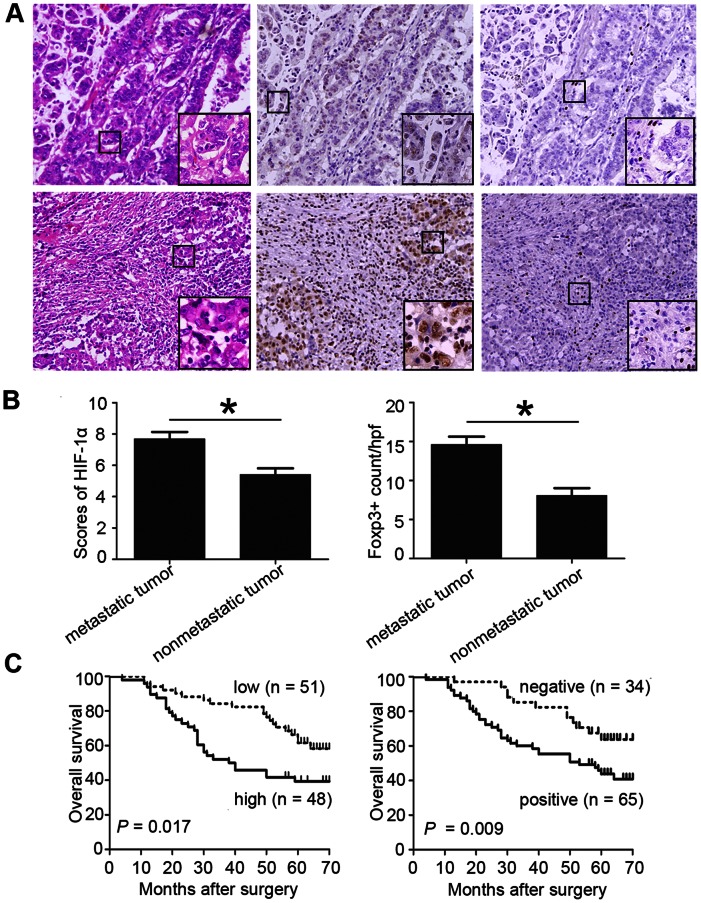
HIF-1α and Foxp3 expression in gastric cancer specimens.(A) Foxp3 and HIF-1α expression in gastric cancer specimens (serial sections) were determined by H&E and immunohistochemistry staining. Representative H&E staining (upper-left and down-left) and images from tumors expressing small (upper and upper-right) or large (down and down-right) amounts of HIF-1α and Foxp3, respectively. (B) Histograms showed that the expression of HIF-1α (left) or Foxp3 (right) are significantly higher in metastatic tumor than in nonmetastatic tumor. (C) Kaplan-Meier analysis was performed to compare overall survival between patients with high and low expression of Foxp3 (left) as well as positive and negative expression of HIF-1α (right). Original magnifications: ×100; ×400 (insets); Values represent mean ± SEM. *P<0.001.